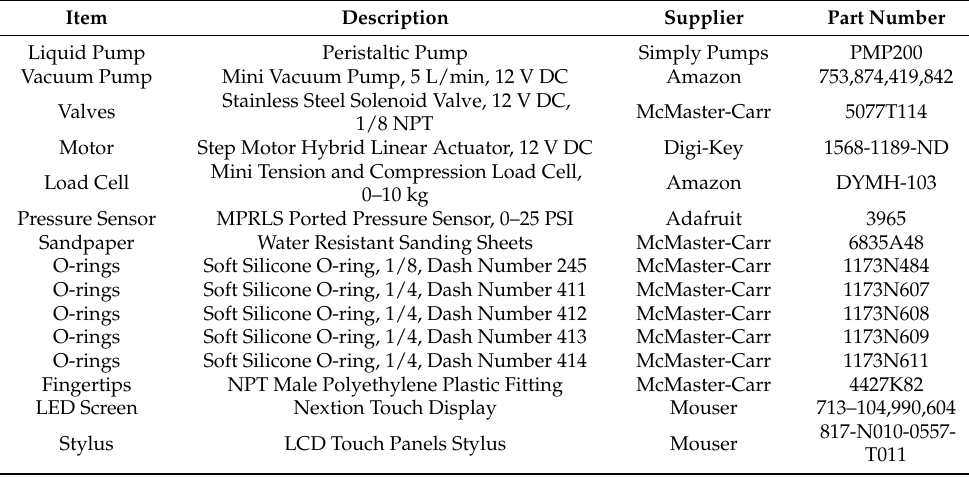
Table A1. List of replaceable parts for the N-GAD.